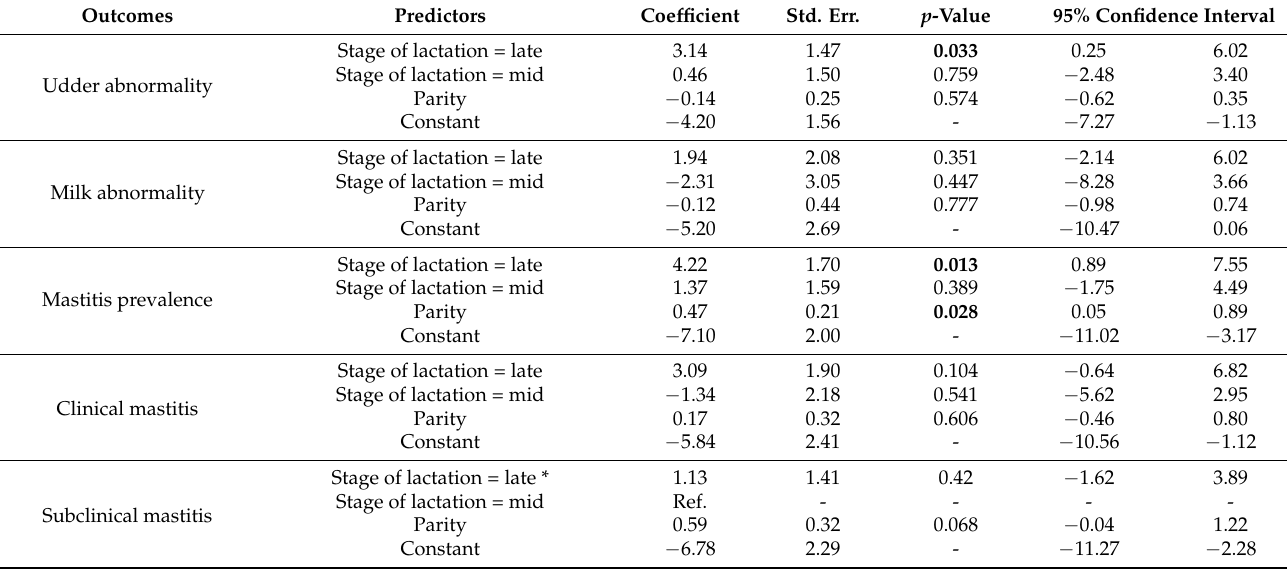
Table 4. Effects of stage of lactation and parity on the prevalence of udder and milk abnormalities, and clinical and subclinical mastitis in camels.